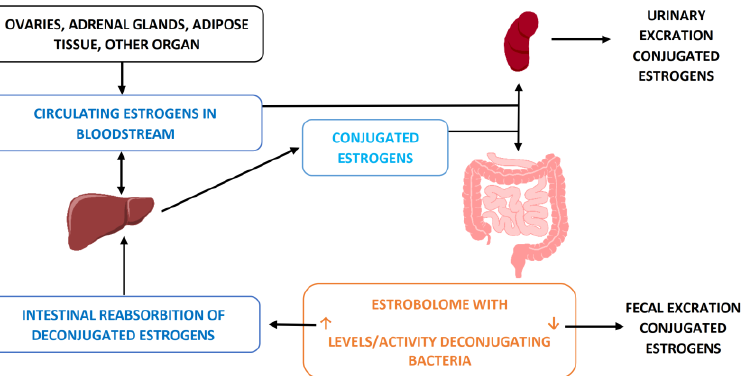
Figure 4. Entero-hepatic circle of estrogens. Some bacteria endowed with b-glucuronidase activity deconjugate estrogens by reintroducing them into the circulation and thus increasing their stimulatory action on the receptors and therefore also the oncological potential, in particular, for hormone-dependent tumors, such as most mammary ones.